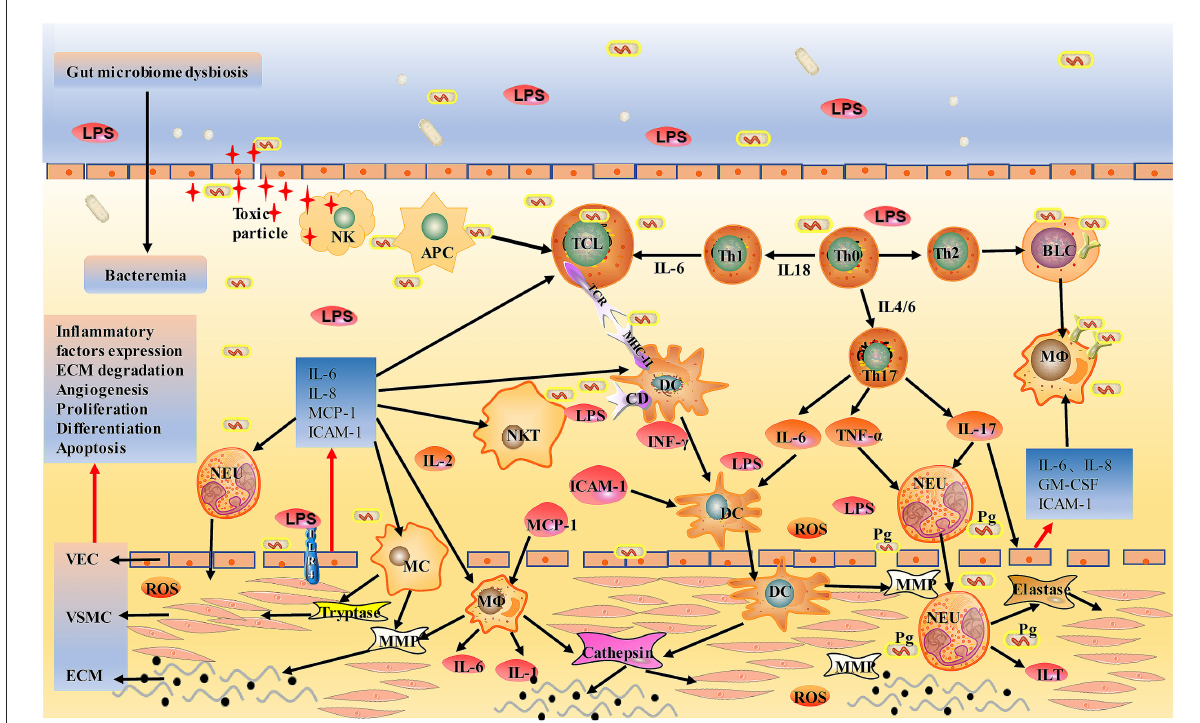
FIGURE2 Schematic of gut bacterial infection mediated direct injury to aorta. After entering the circulation, gut bacteria can be engulfed by immune cells or directly invade the wall of the aorta. Bacterial LPS induces DC, MC, and M 8 to overexpress TLR4 and activates them into endothelial cells, releasing chymase, tryptase, and tissue-damaging hist proteases, destroying the aortic wall. Injured vascular endothelial cells produce IL-6, IL-8, MCP-1, ICAM-1, activate circulating TC, BC, DC, MC, NK, NKT, and M 8 , and promote their local adhesion and penetration, leading to metastasis to lesions. LPS also induces Th0 differentiation into Th1 and Th2, further activating effector T cells and plasma cells that directly kill bacteria. NK cells are activated by cytokines, bind to infected vascular endothelial cells, release toxic particles, and induce apoptosis. Pg participates in the onset of AAA through neutrophil activation, and neutrophil activation is associated with the formation of NET in ILT. AAA is eventually led by mechanisms, such as extracellular matrix degradation, abnormalities of angiogenesis, proliferation, differentiation, apoptosis, and atherosclerosis. MCP-1, monocyte chemoattractant protein-1; ICAM-1, Intercellular adhesion molecule-1; Pg, Porphyrinum gingivalis ; NET, neutrophil extracellular traps; ILT, intraluminal